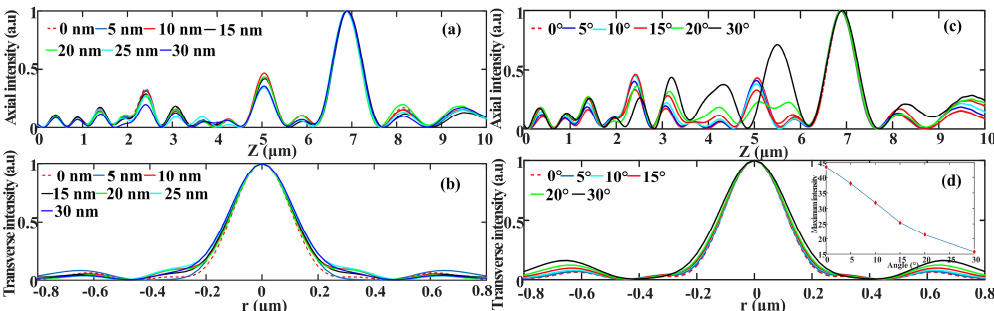
Figure 8. ( a , b ) The focusing performance of slot width deviation changing from 0 nm to 30 nm; ( c , d ) The focusing performance with the inclined sidewalls changing from 0 to 30°.